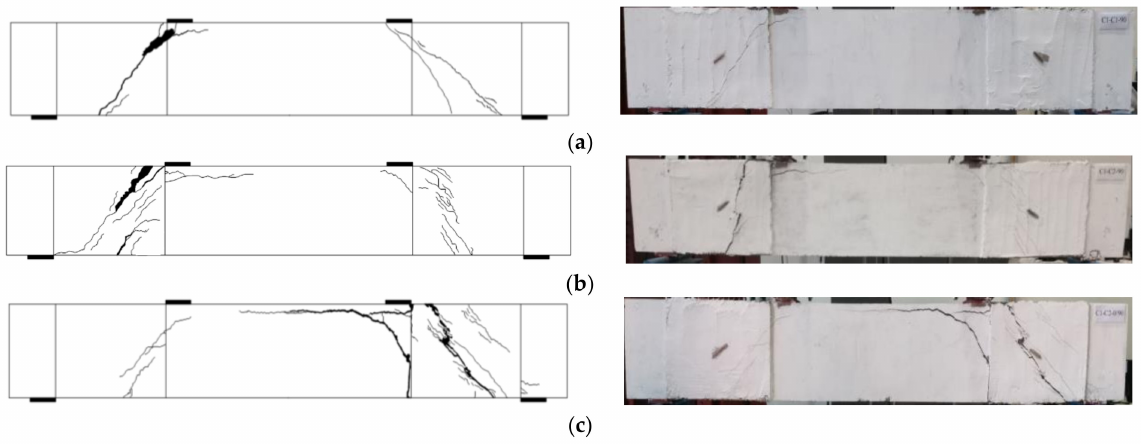
Figure 7. Crack pattern at failure of specimens in group A: ( a ) NS-C1-90; ( b ) NS-C2-90; ( c ) NS-C2-0/90.